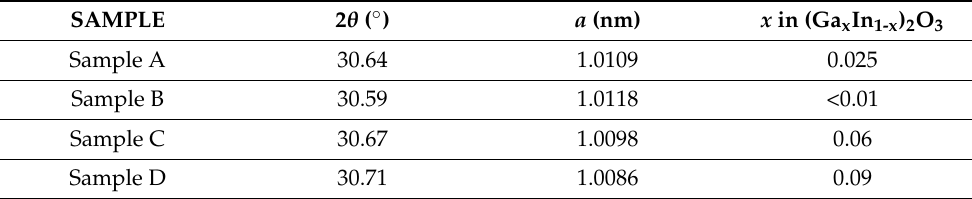
Table 1. Parameters evaluated from the XRD analysis: angle position of the (2 2 2) peak, lattice parameter and estimated composition of the NW assembly of the different synthesized